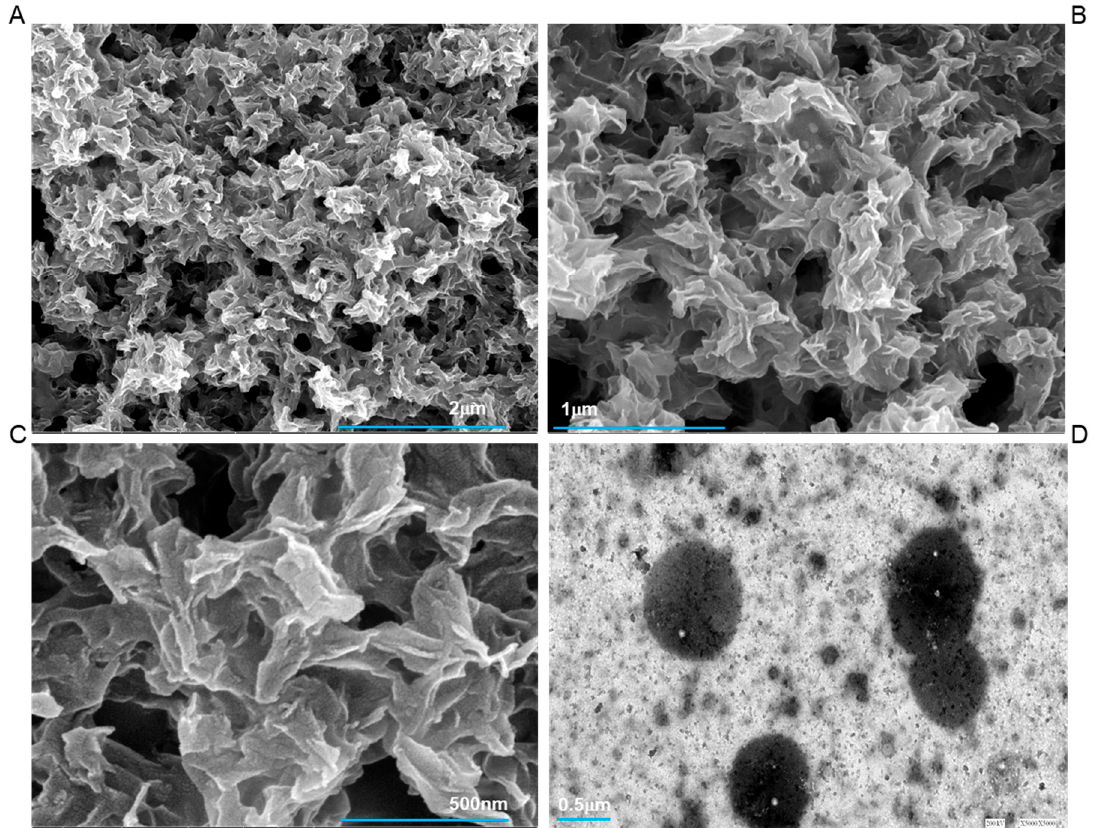
Figure 3. FESEM micrograph of calcium phosphate mineral products in the presence of deglycosylated tooth protein extract. ( A – C ) shows the absence of systematized mineralization and results in only random aggregates of calcium and phosphates. The corresponding TEM image with the deglycosylated extract is shown in ( D ). All scale bars with size are placed at the lower part of the images.